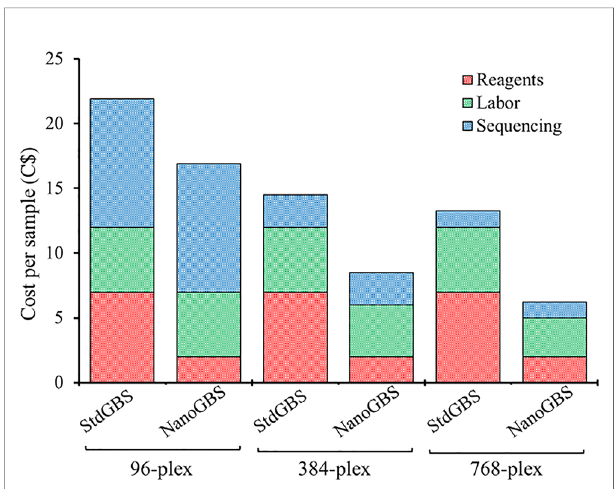
FIGURE 2 | Detailed estimation of cost of genotyping-by-sequencing (GBS) genotyping per sample using standard GBS (StdGBS) vs. NanoGBS methods in three different multiplexing